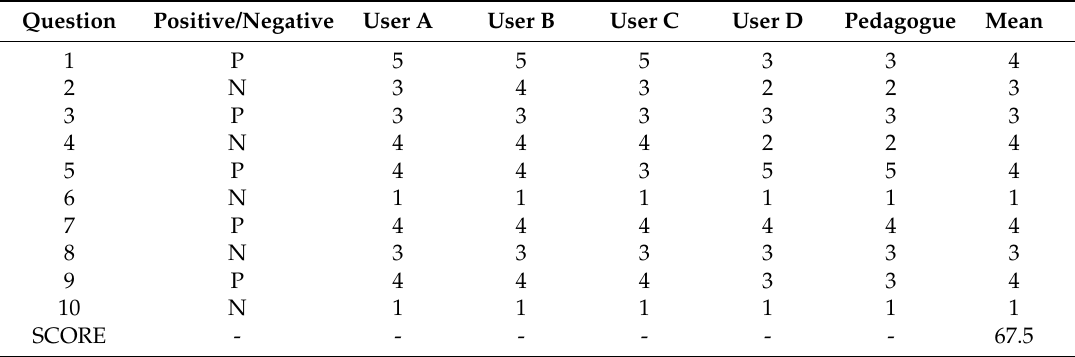
Table A1. The System Usability Scale (SUS)